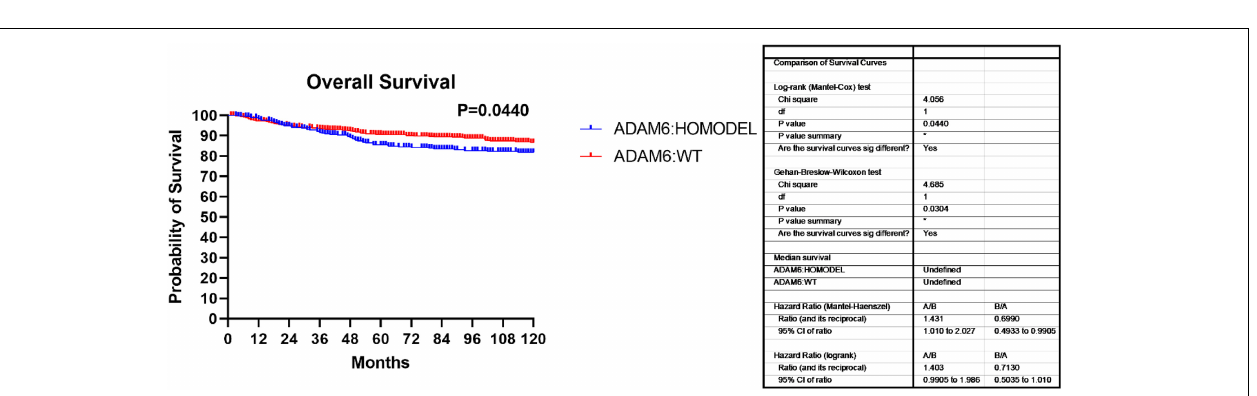
FIGURE 4 | Overall survival showing the ADAM6:HOMDEL versus WT:ADAM6.